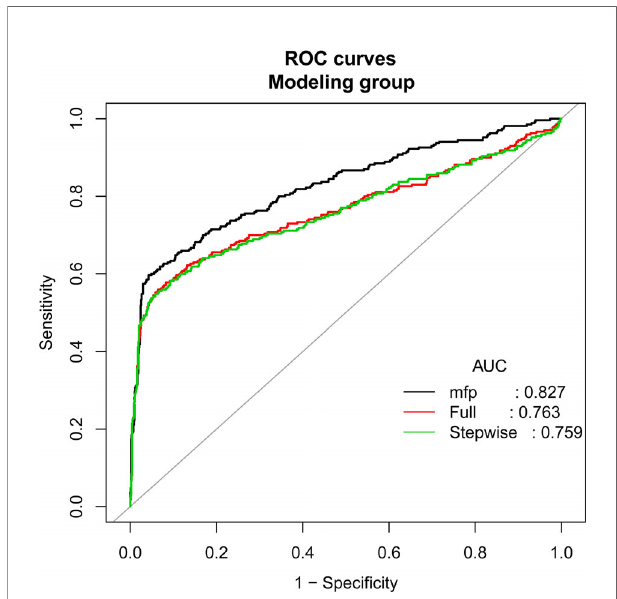
FIGURE 2 | Discrimination for the training cohort. The AUC (mfp) of the modeling group is 0.827 (95%